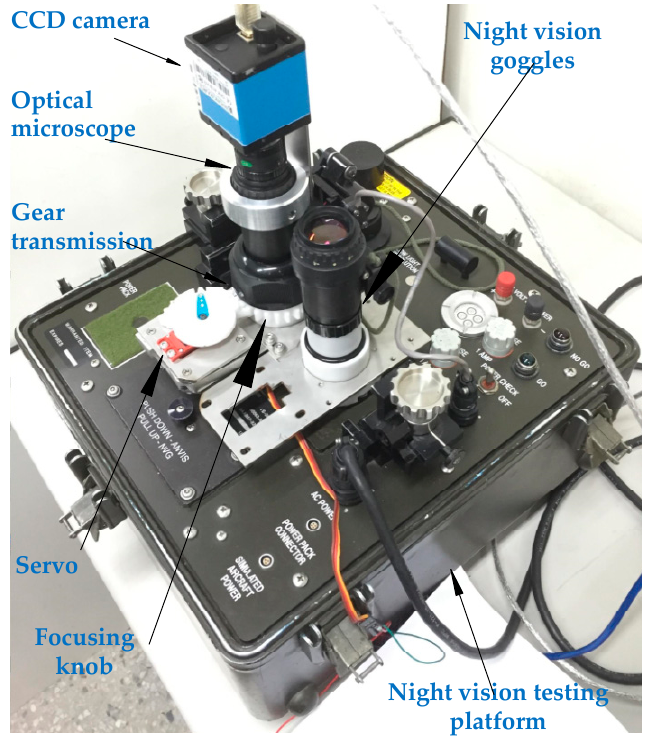
Figure 1. System installation.